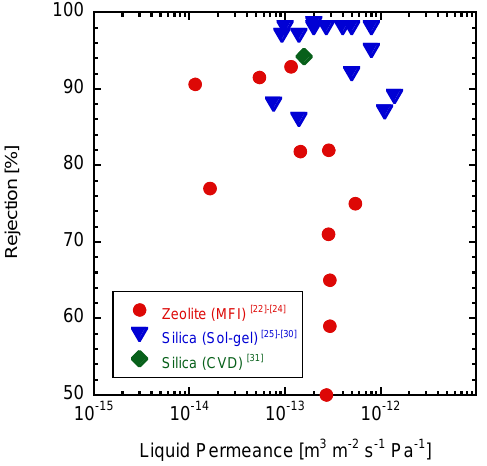
Figure 1. NaCl solution RO performance through the inorganic membranes.